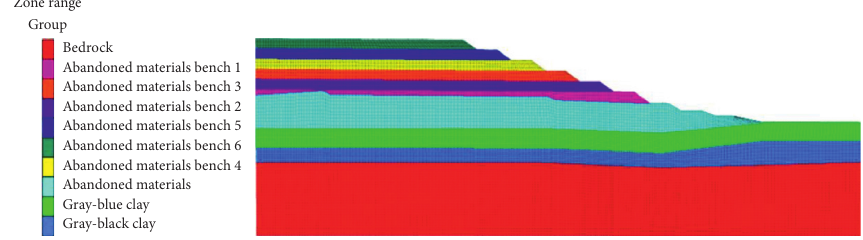
Figure 2: Numerical calculation model of the dump.